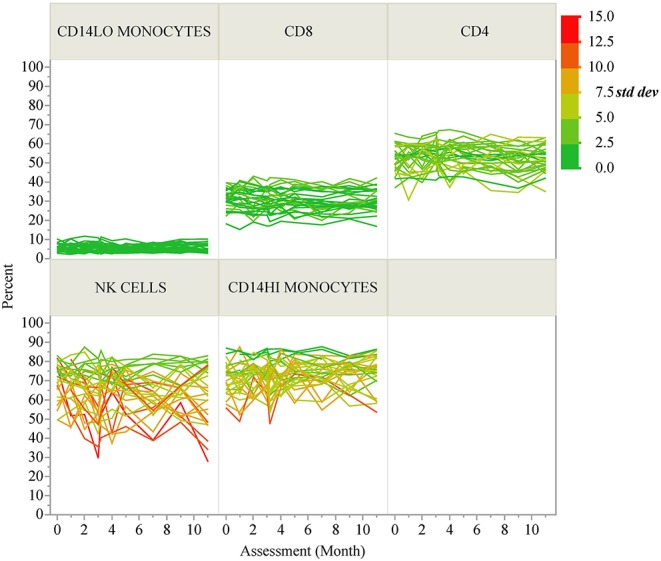
Longitudinal variability of selected immune cell populations. Spaghetti plots show the longitudinal variability of five selected immune populations. Individual lines correspond to T1D participants and the lines are colored according to the standard deviation of each participant's repeated assessments during the study.